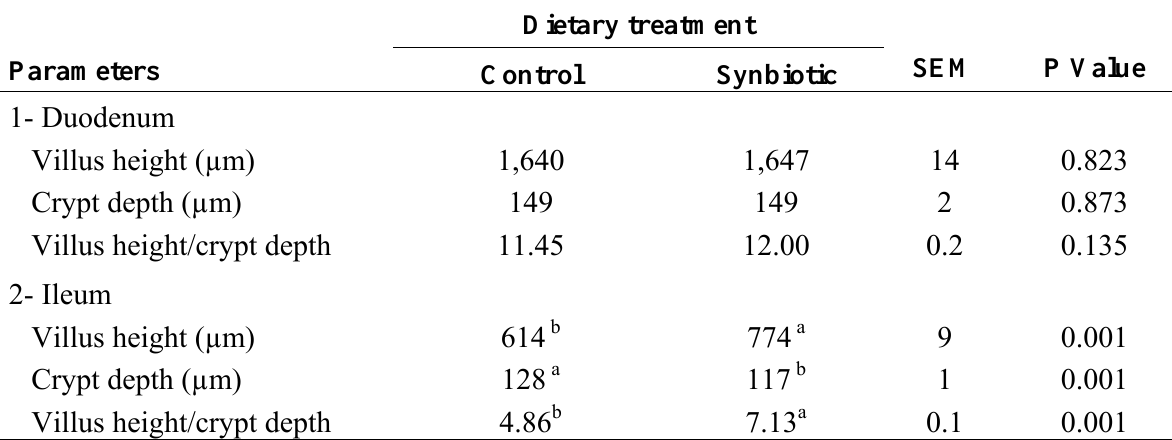
Table 3. Effects of dietary inclusion of synbiotic on the intestinal morphological parameters of